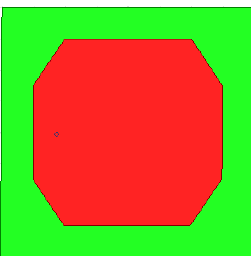
Fig. 1.2 Structure of Antenna 1 using HFSS